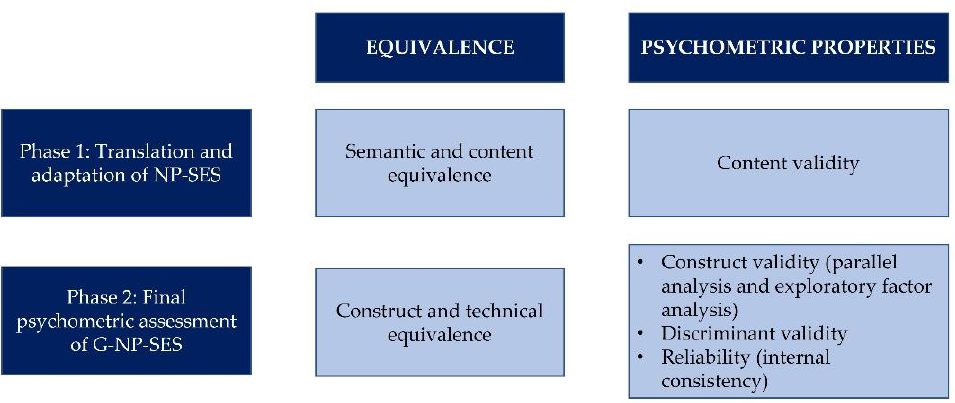
Figure 1. Procedure for establishing equivalence and psychometric properties of the G-NP-SES. Abbreviations: G-NP-SES. Galician version of the Nurse Prescribing Self-Efficacy Scale; NP-SES. Nurse Prescribing Self-Efficacy Scale.